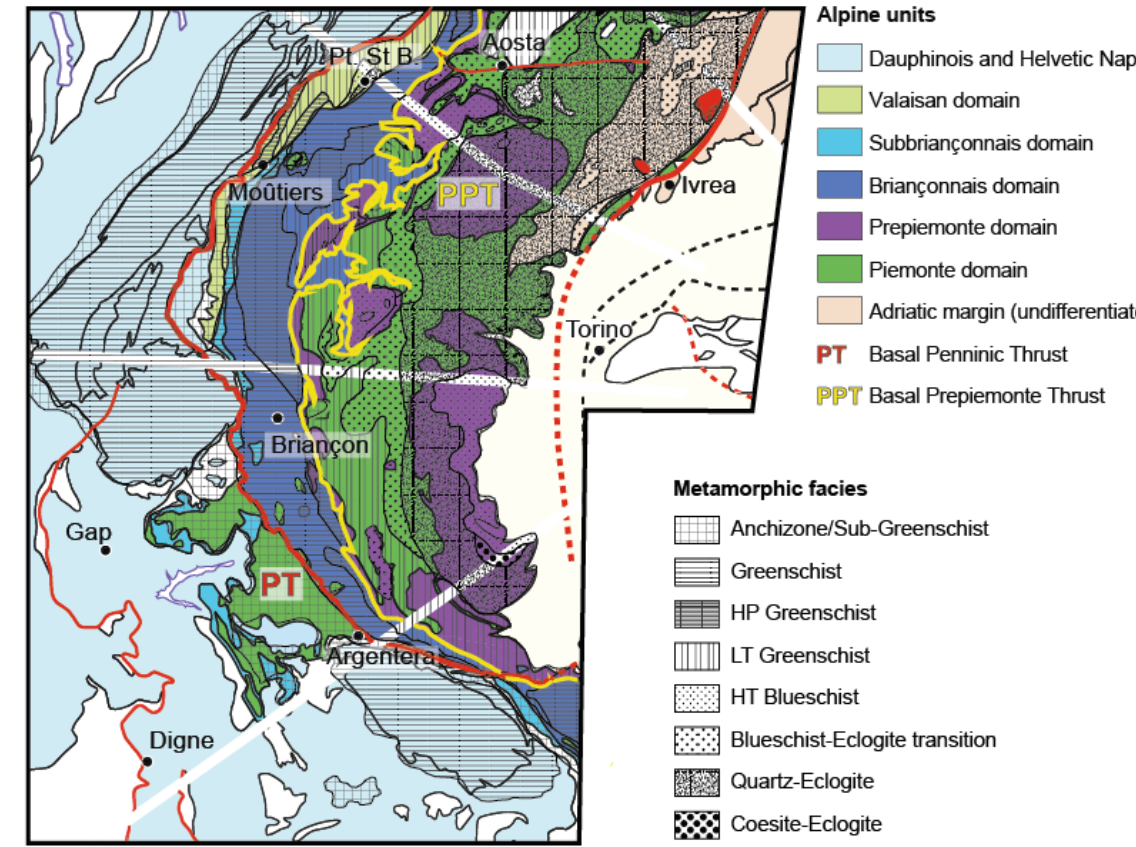
Figure 4. Map showing the distribution of the main Alpine units (colors) discussed in the text (modified from [24]) together with the distribution of the metamorphic facies (patterns) in the Western Alps (from [28]). Note that no high-pressure facies can be found external to the Basal Prepiemonte Thrust (PPT) as defined in the present study (see text for details and discussion). The white strips correspond to the trace of the seismic lines displayed in Figure 2e. Abbreviation: P. St B.: Petit Saint Bernard.